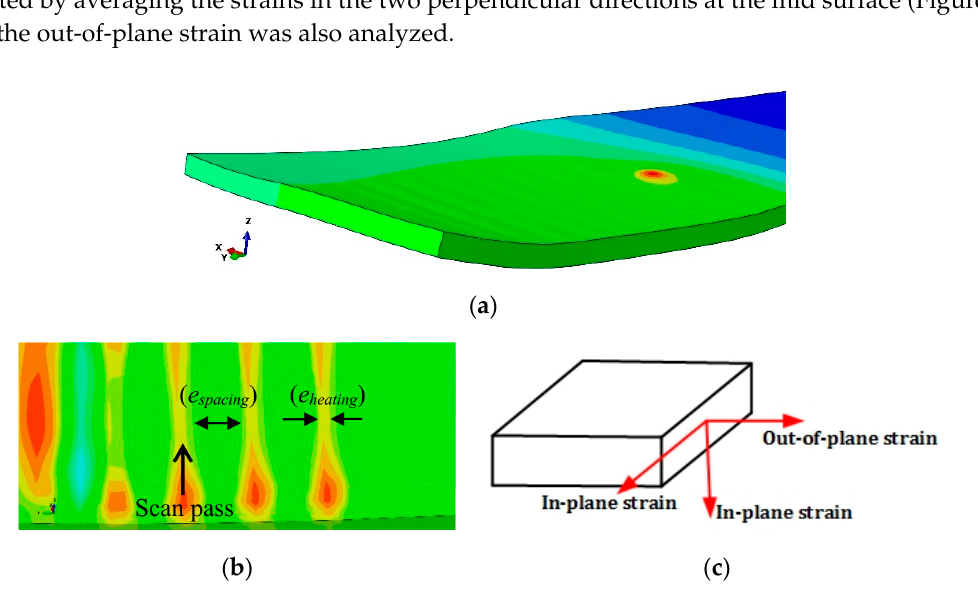
Figure 3. ( a ) Model with the clamp; and ( b ) the computational mesh used for 3D with plane-symmetry finite element analysis.